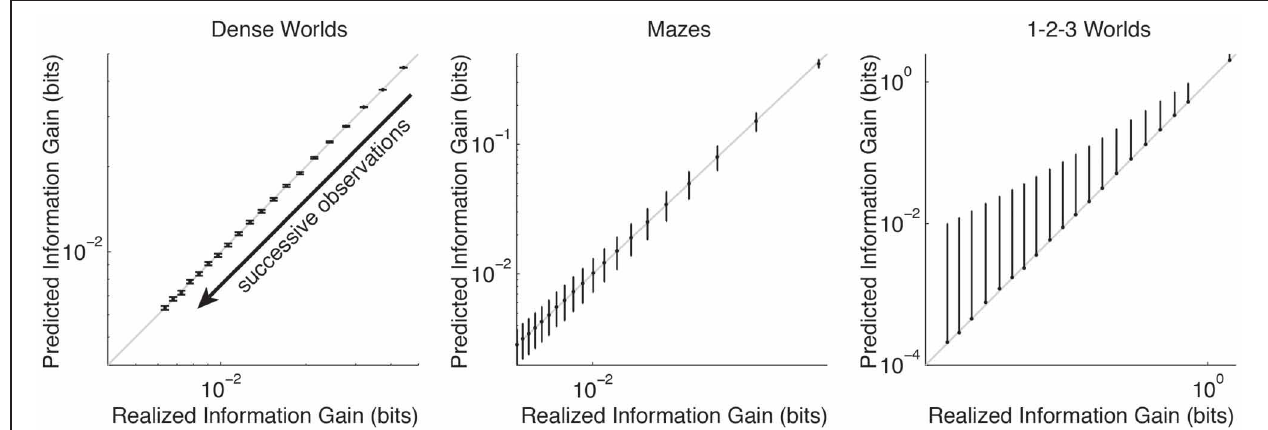
deviations (only plotted above the mean for 1-2-3 Worlds). The arrow indicates the direction of increasing numbers of observations (top-right = none, bottom-left = 19). The unity lines are drawn in gray.